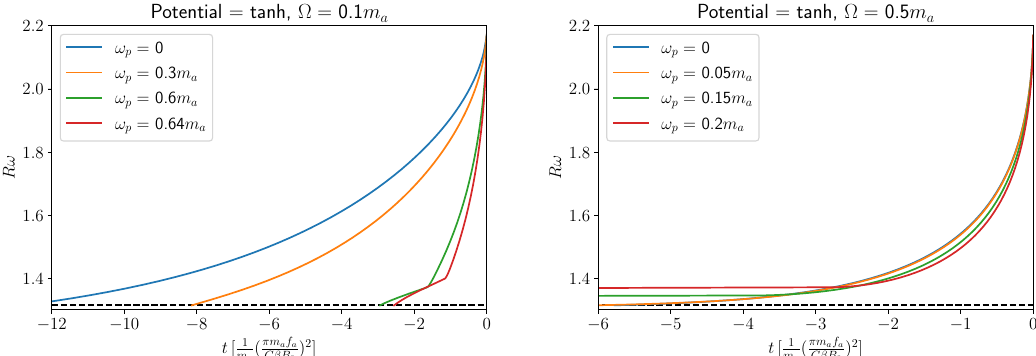
Figure 15 . The product Rω as a function of time for the tanh-potential for a few different values of the external magnetic field frequency Ω and the plasma frequency ω p . The dashed horizontal line shows the corresponding initial value, with ω ( t = 0) = ω crit